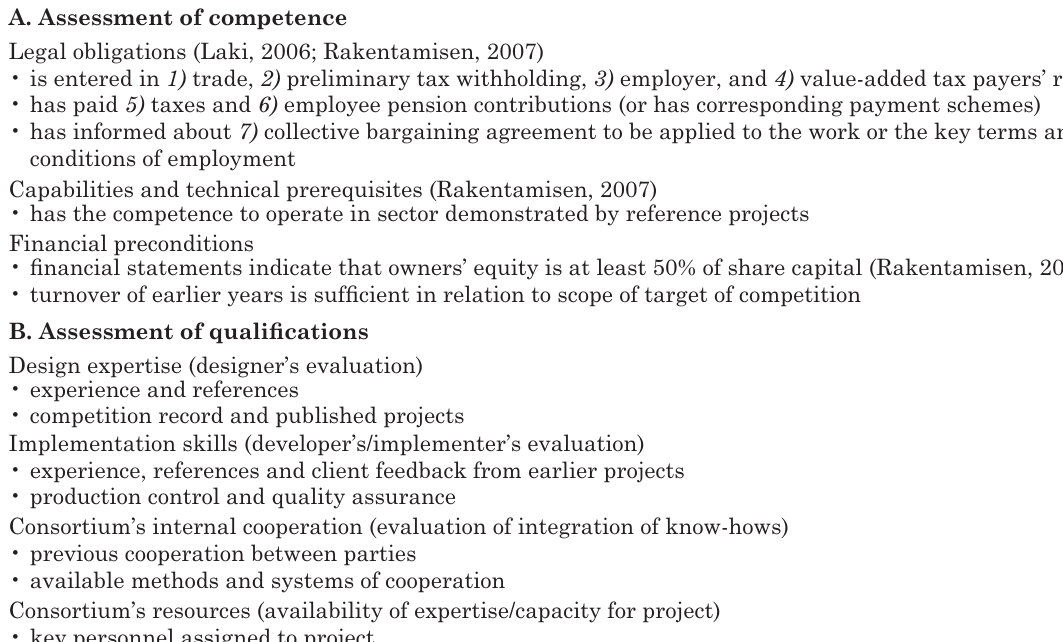
Table 1. Example criteria for selection of planning and implementation